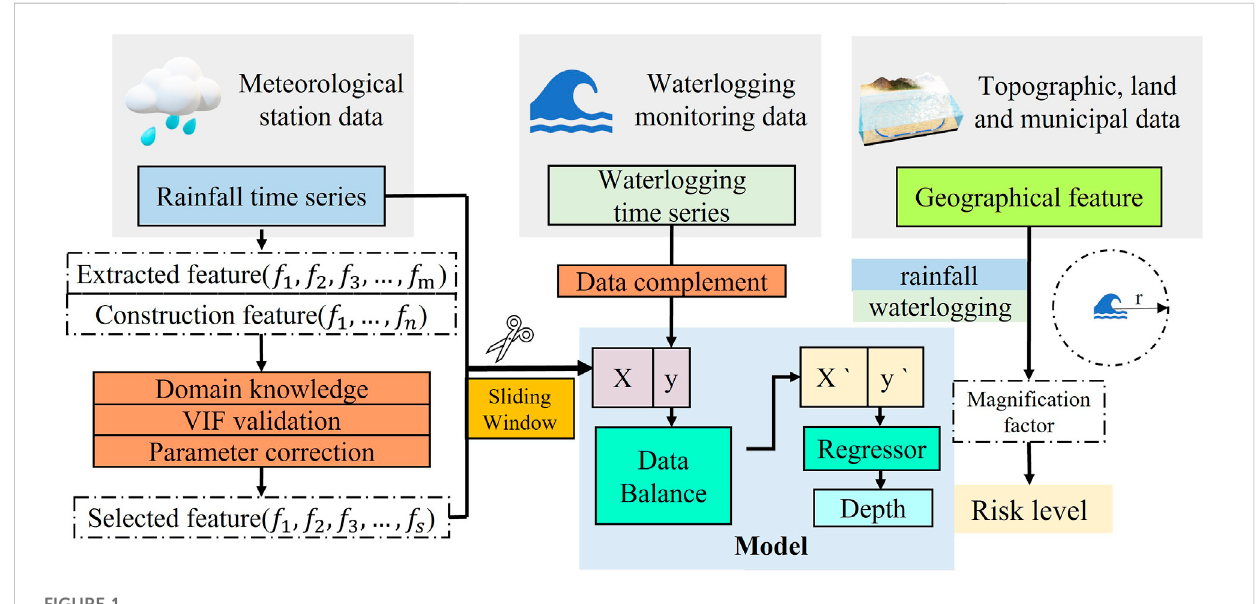
FIGURE 1 The framework of the method.